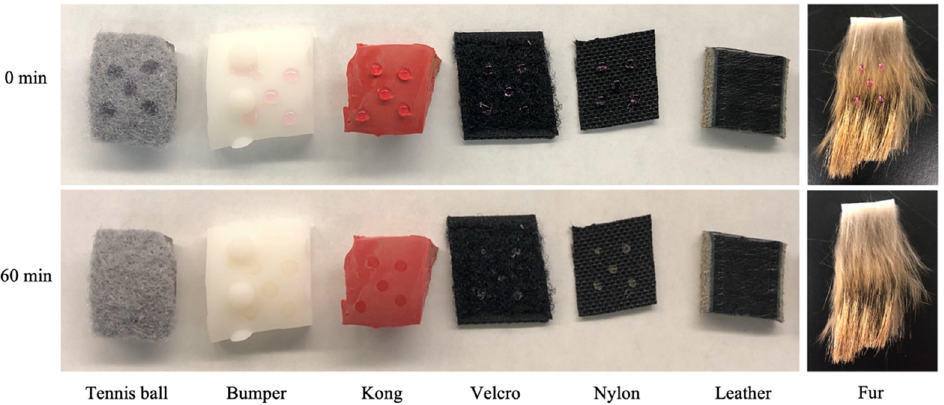
Figure 1. Droplet drying rates. Images show the effect of 0 and 60 min drying times on 10 μ L droplets of growth medium deposited on various surfaces. Drying occurred at ambient temperature and humidity inside a biosafety cabinet.